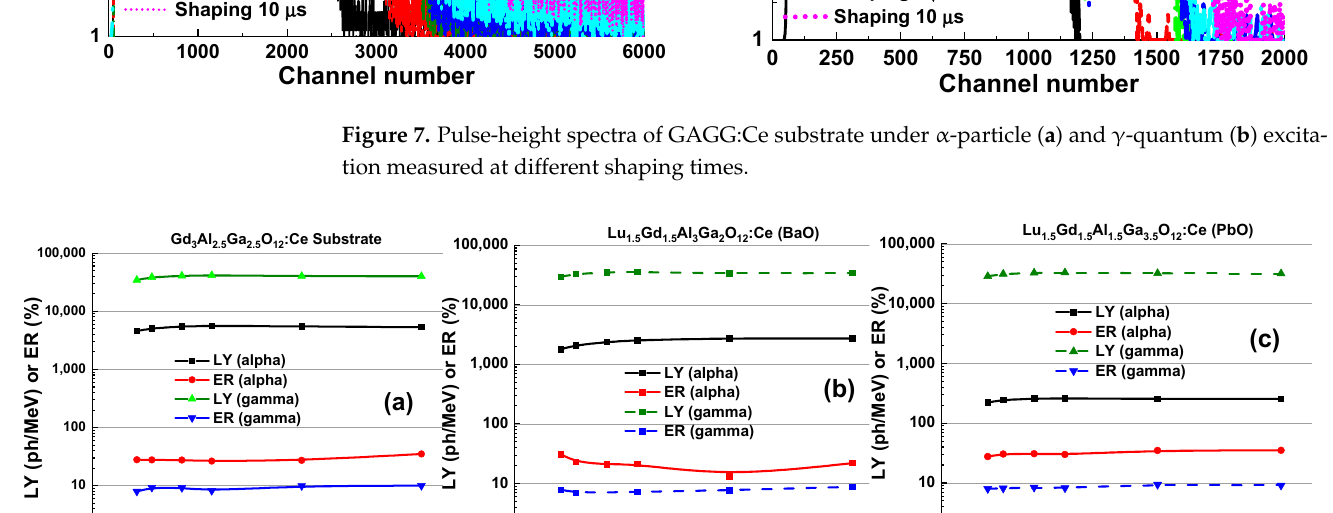
Figure 8. Dependences of LY and energy resolution (ER) of the GAGG:Ce substrates ( a ) and Gd 1.5 Lu 1.5 Al 1.5 Ga 3.5 O 12 :Ce/ GAGG:Ce composite scintillators grown from BaO- ( b ) and PbO-based ( c ) fluxes, respectively, as the function of shaping time measured under various γ -rays of 137 Cs and α -particles of 4.8 MeV 241 Am (CERN 241 Am alpha source).